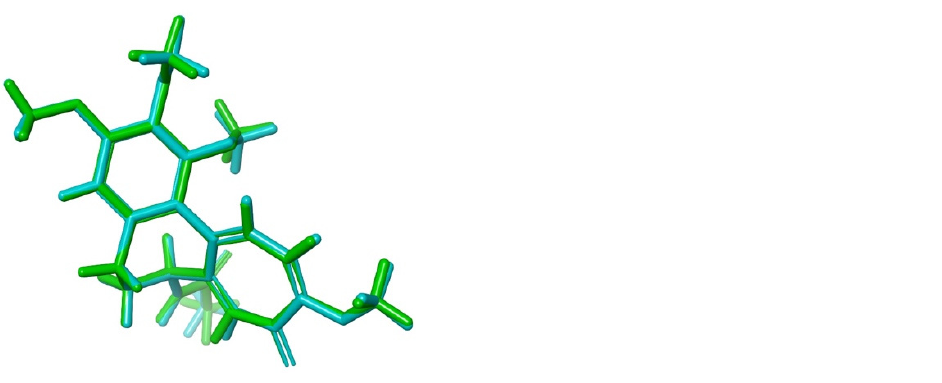
of the native ligand colchicine within tubulin protein structure (PDB ID: 6XER), RMSD value = 0.18 Å.